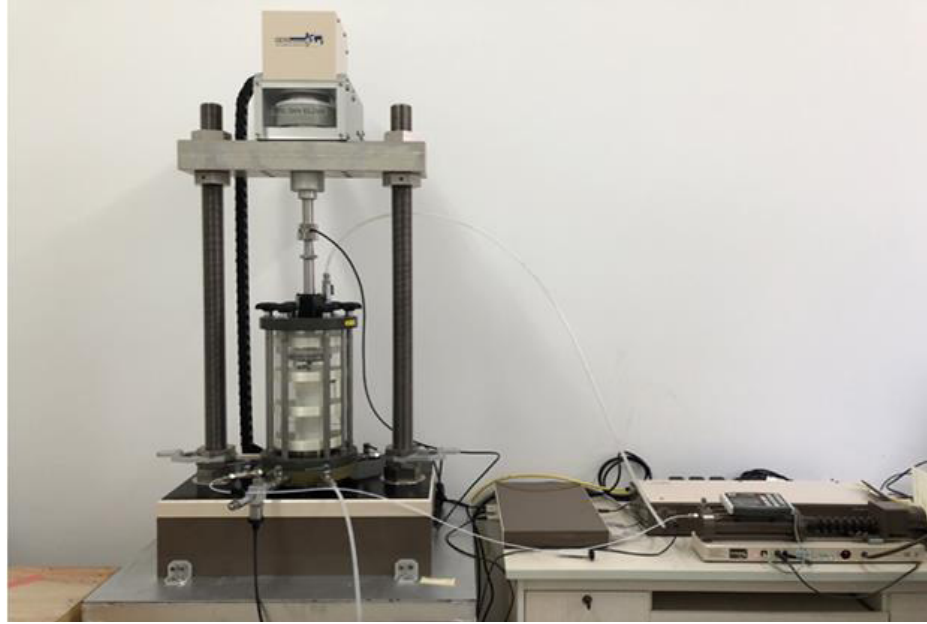
Figure 1. Eldyn dynamic triaxial